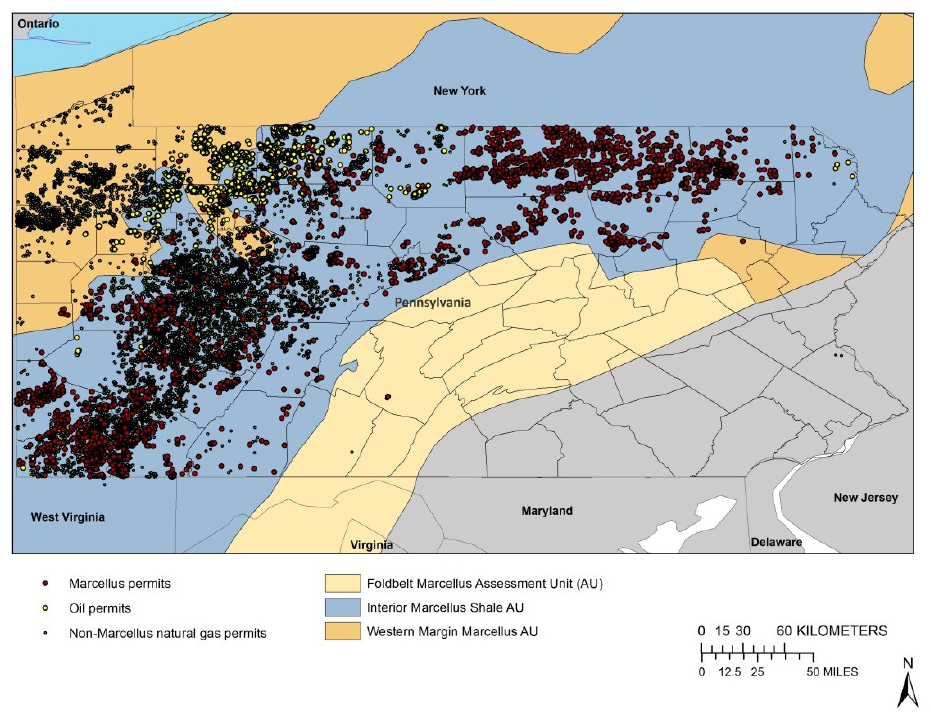
Figure 1. The distribution of unconventional (Marcellus) and conventional (non-Marcellus) natural gas permits within Pennsylvania. Base-map data courtesy of the U.S. Geological Survey National Atlas [28].